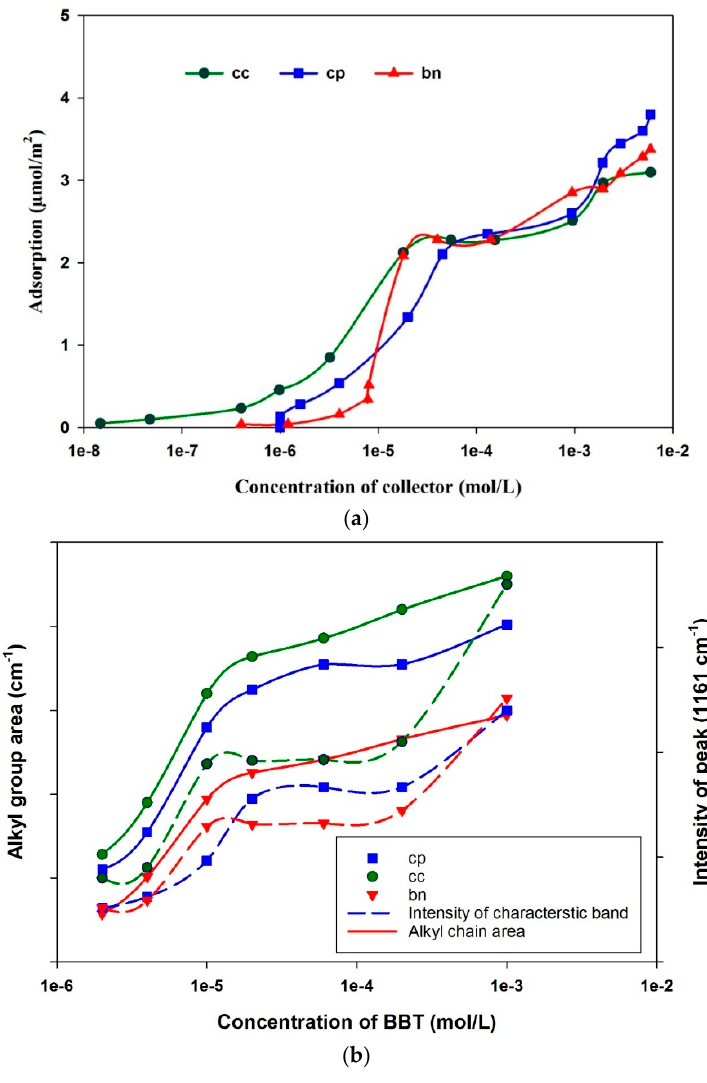
Figure 7. ( a ) Adsorption of thionocarbamate on the copper sulphide surface at pH 8; ( b ) Intensities of characteristic BBT band and area under alkyl chain bands for chalcopyrite, chalcocite and bornite (FTIR studies).cp-chalcopyrite, cc-chalcocite, bn-bornite, ca-calcite, qz-quartz.